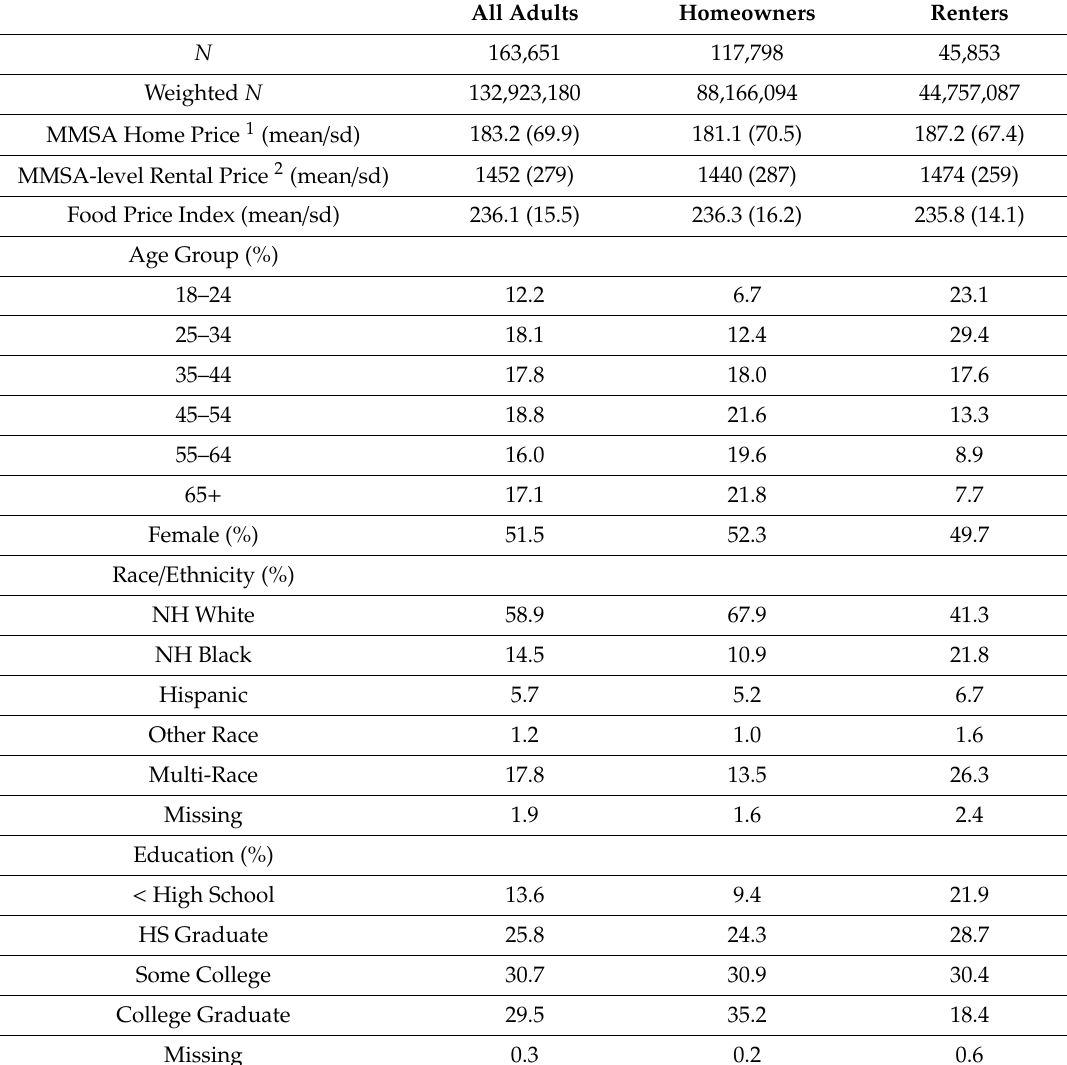
Table 1. Selected descriptive statistics of study sample, stratified by home ownership status. All Adults